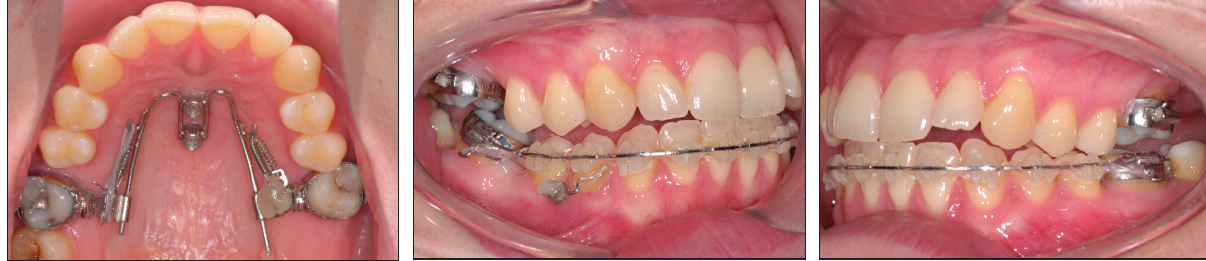
Figure 7. Intra-oral photographs 12 months into treatment highlighting the excellent intrusion achieved for maxillary second molars during mesialisation.